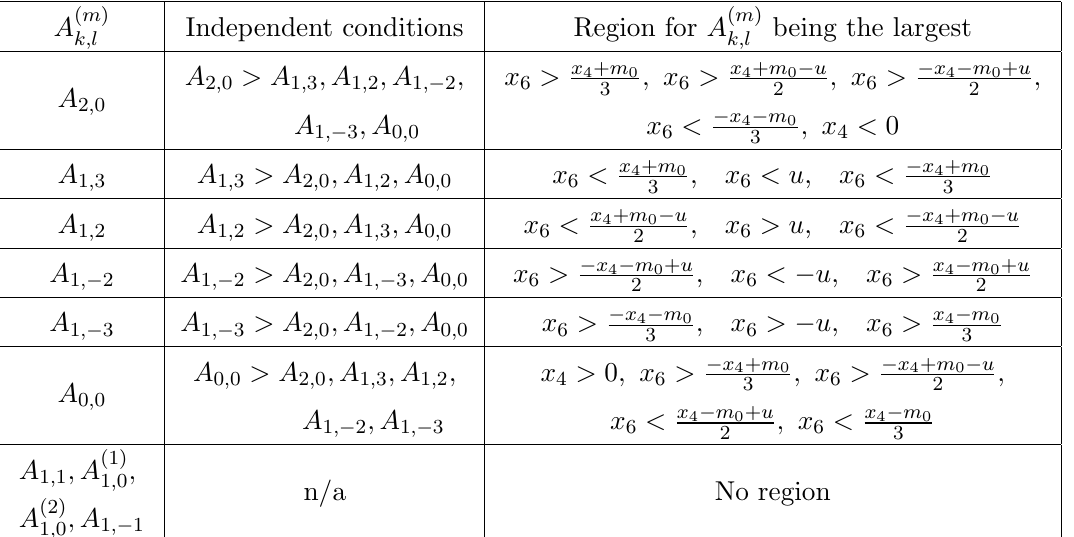
0 ) ’s for Region 3 (3.22) k 0 ;l 0